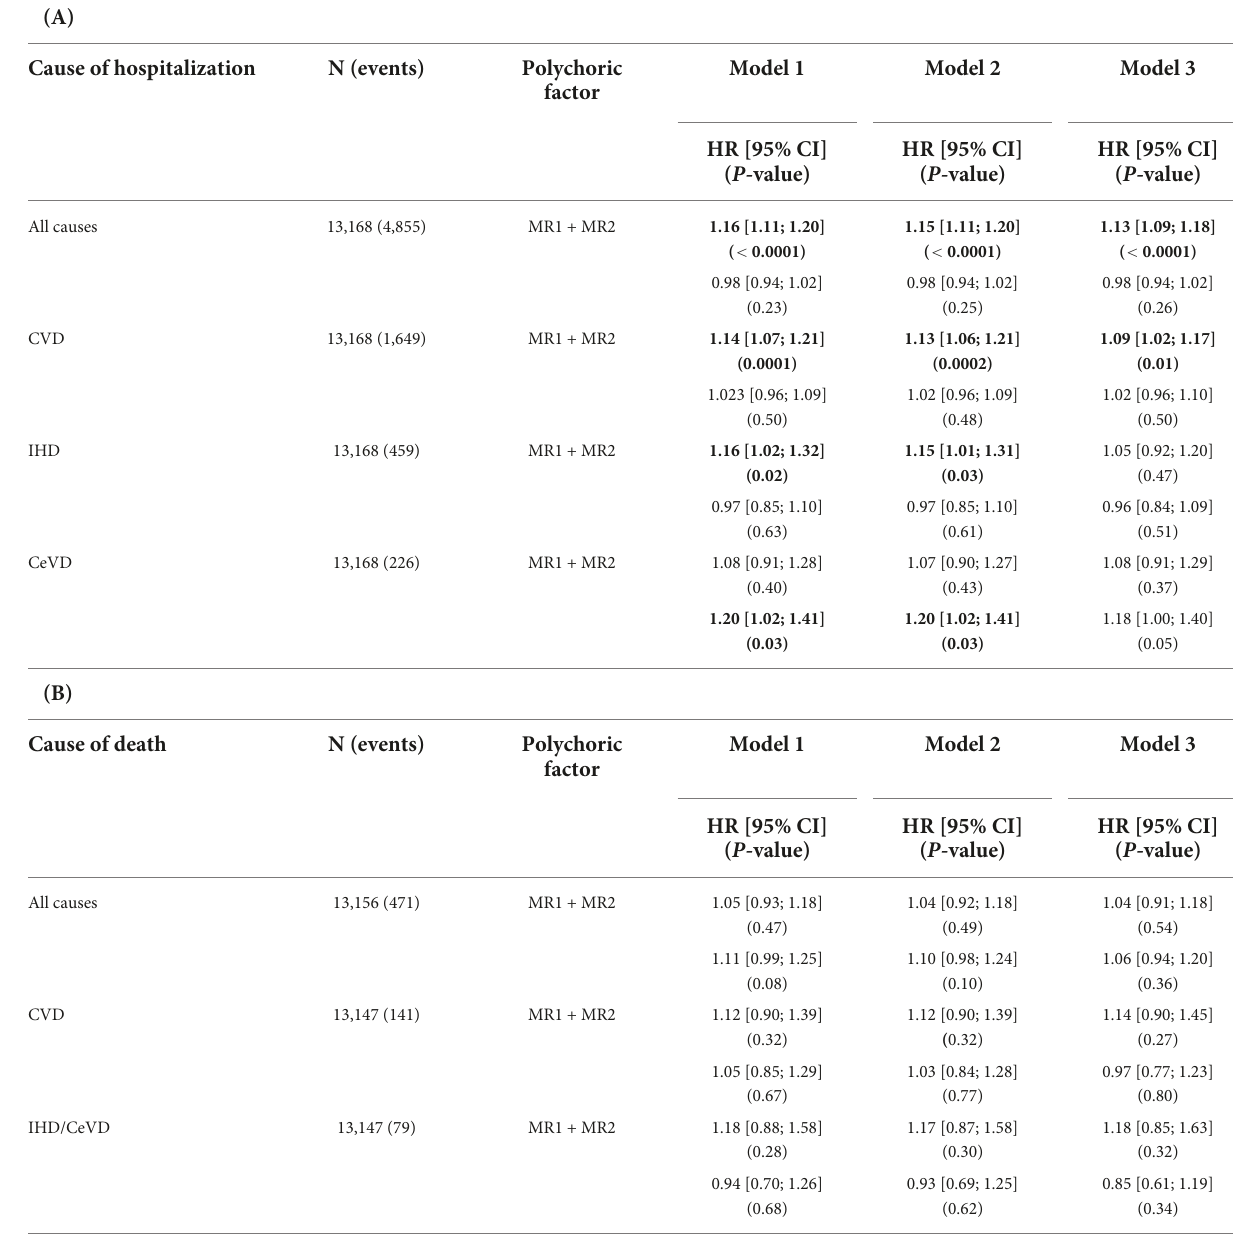
TABLE 3 Associations of depressive symptom factors with incident (A) hospitalization risk and (B)